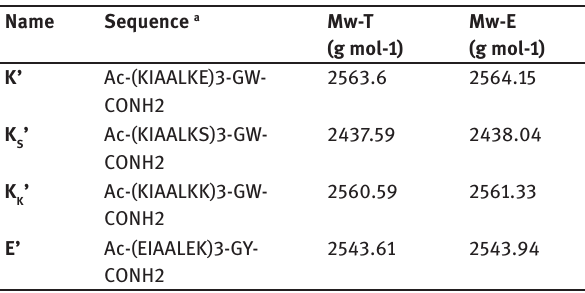
Table 5: Fluorescent labeled peptide primary structure.